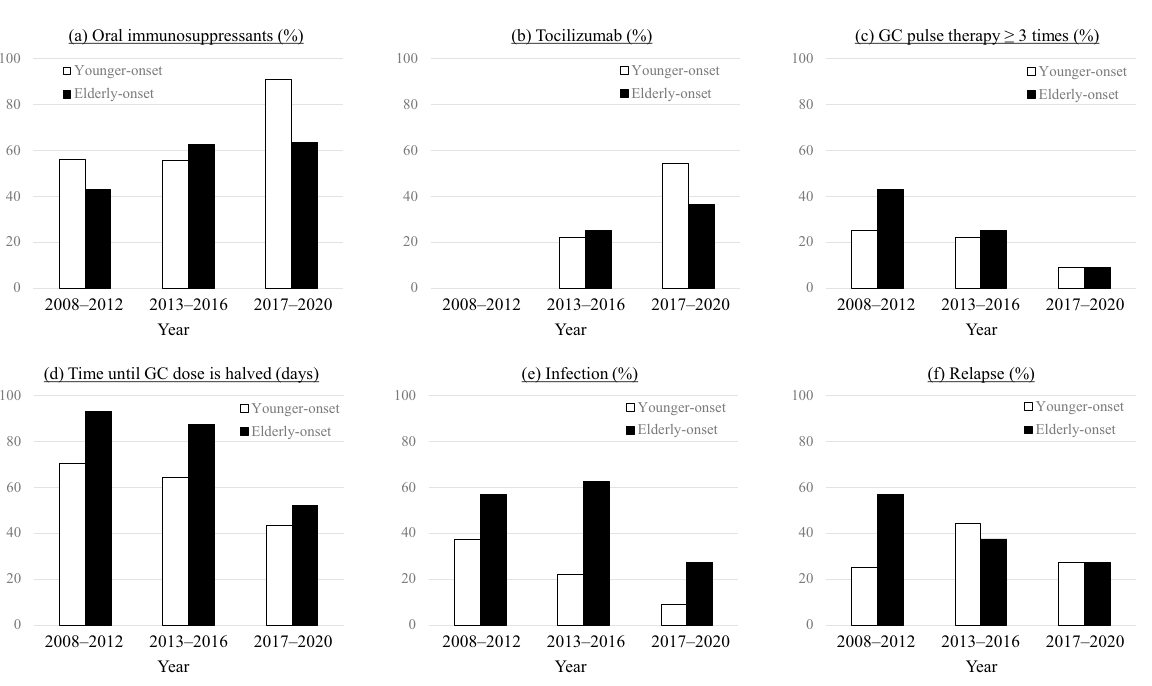
Figure 2. The trend of treatment status over time in patients with elderly onset and younger-onset adult-onset Still’s disease. GCs